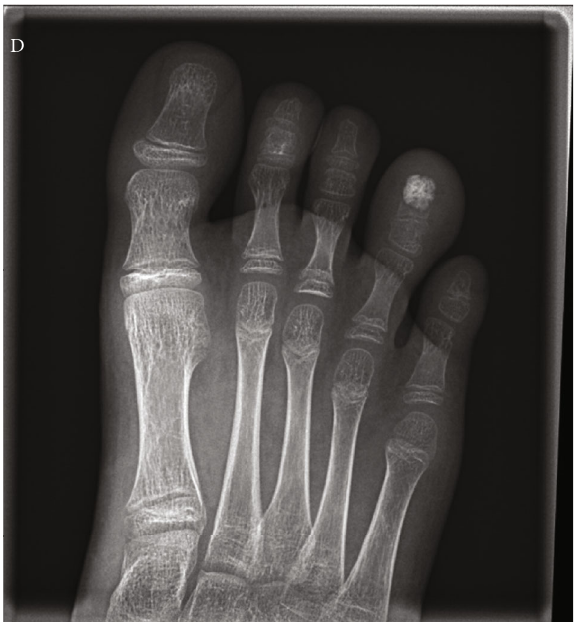
Figure 1: X-ray demonstrating the large nidus and the preservation of the proximal epiphysis. The important swelling of the fourth toe is well demonstrated.